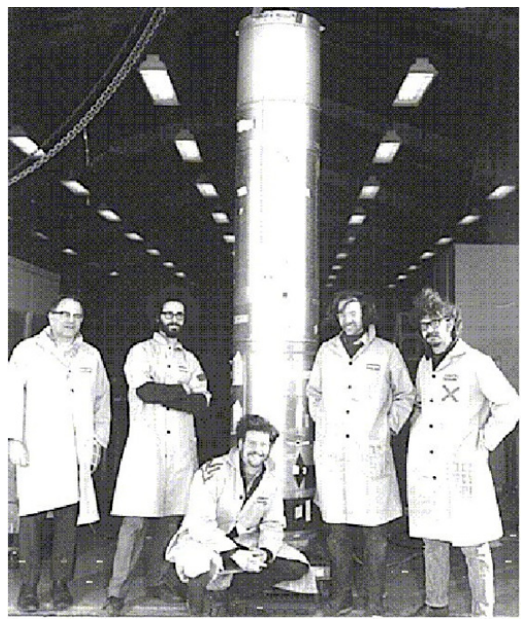
Figure 4. Rocket 17.09 and the science team. From left to right, Prof. Robert Novick, Director of the